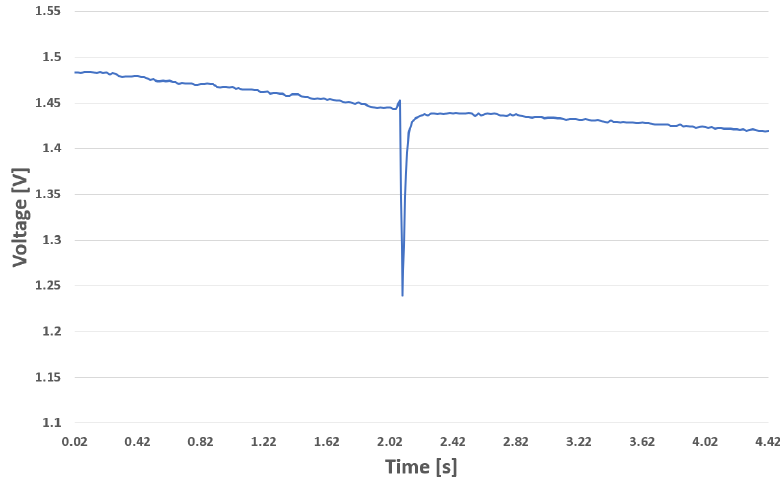
Figure 1. Discharge